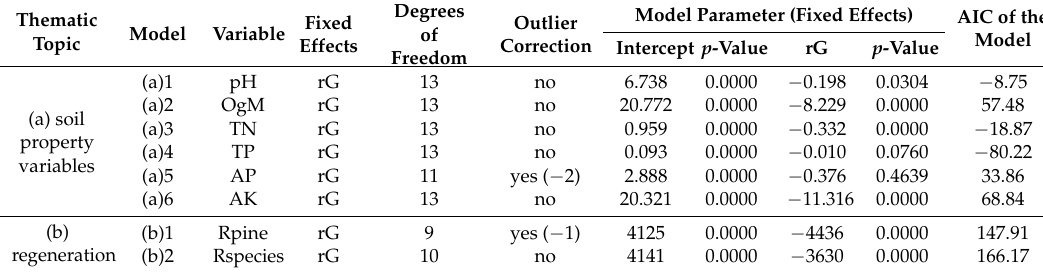
Model Parameter (Fixed Effects) AIC of the